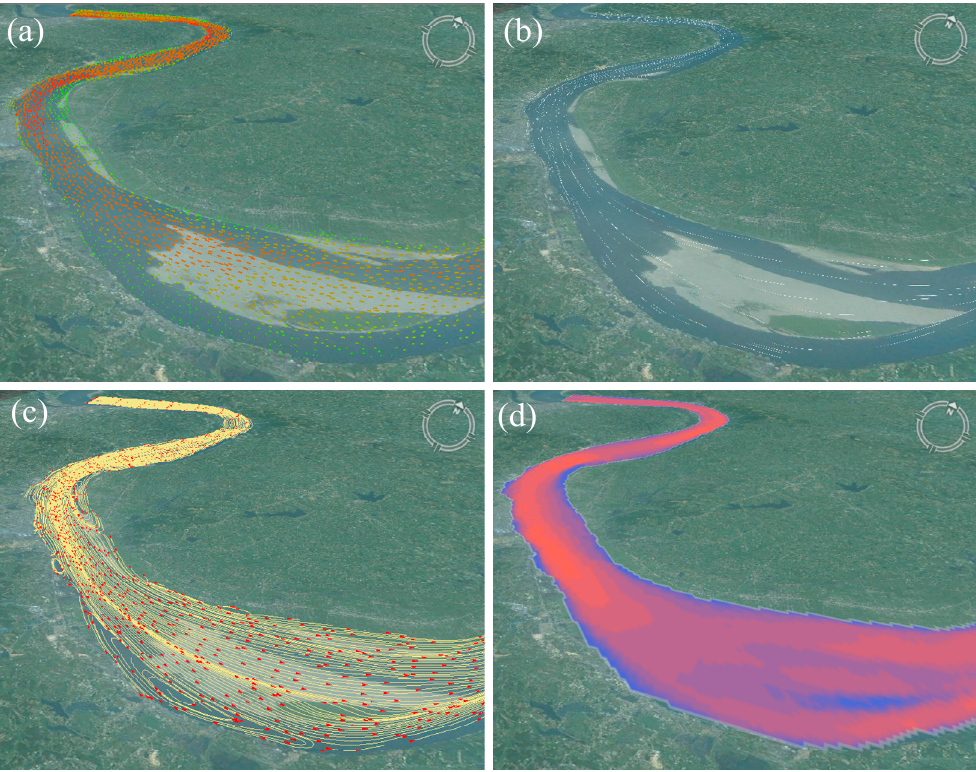
Figure 12. Flow visualization: ( a ) particle tracking (arrow marker); ( b ) particle tracking (ribbon trail); ( c ) streamline rendering; ( d ) contour surface rendering.